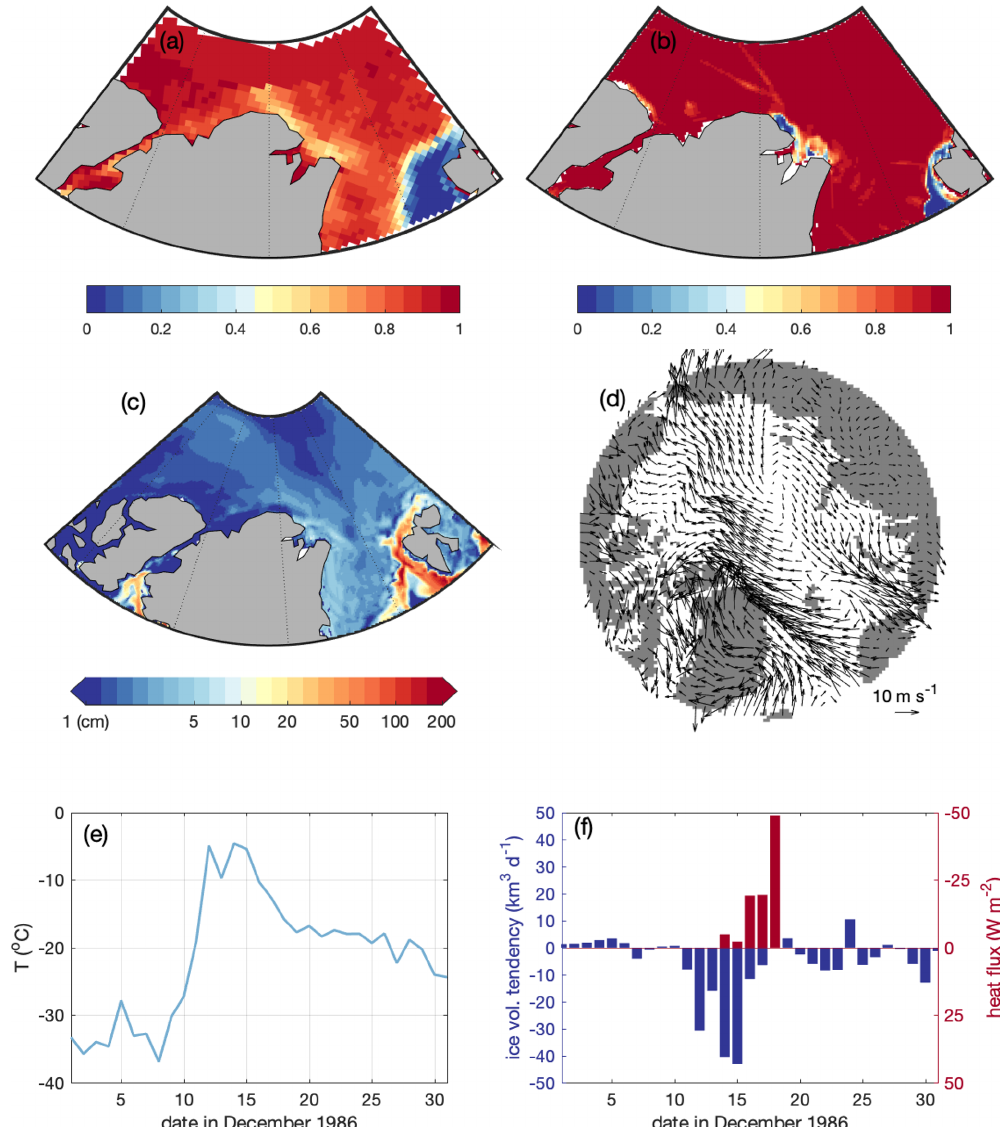
Figure 9. Mean sea ice concentration (NASA Team algorithm) on 15 December 1986 over the northern Greenland region from (a) the Nimbus-7 Scanning Multichannel Microwave Radiometer (SMMR) and (b) the RASM hindcast simulation. (c) Monthly integrated sea ice melt (top, lateral, and basal) for December 1986 and (d) near-surface (at 10m) wind fields on 12 December 1986 from the RASM hindcast simulation. (e) RASM daily near-surface air temperature ( T ; ◦ C) from the nearest grid cell to Station 04301 (Cape Morris Jesup) (f) Time rate of change in the RASM daily sea ice volume (km 3 d − 1 ) (blue) due to dynamic tendency during December 1986, spatially integrated for the region shown in Fig. 4a. Daily mean net turbulent (sensible and latent) heat flux (Wm − 2 ) (red) is also shown over the same region where sea ice thickness is less than 10cm from the RASM hindcast simulations. The negative values indicate loss from the